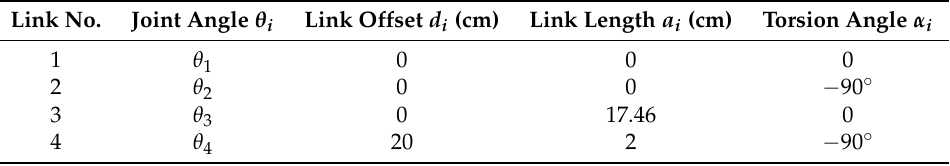
Table 1. The modified DH parameters for a single robotic arm Link